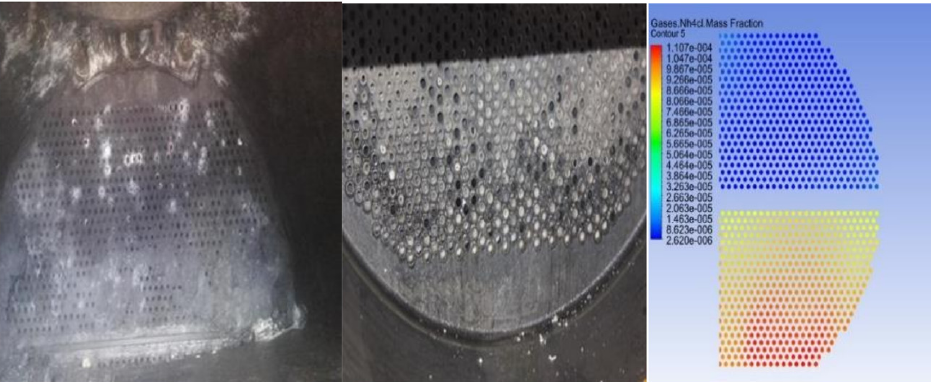
Figure 25. Comparison of actual corrosion locations to simulated